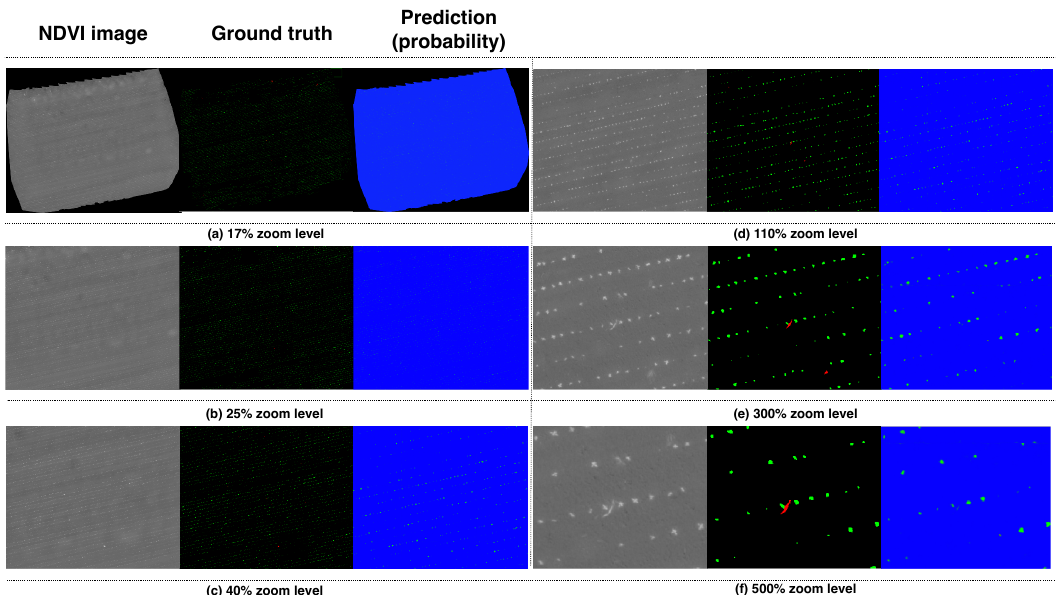
Figure 14. Quantitative results for the Sequoia testing dataset (dataset 005). Each column corresponds to an example input image, ground truth, and the output prediction. Each row ( a – f ) shows a different zoom level on the orthomosaic weed map. The color convention follows bg, crop, weed . These images are best viewed in